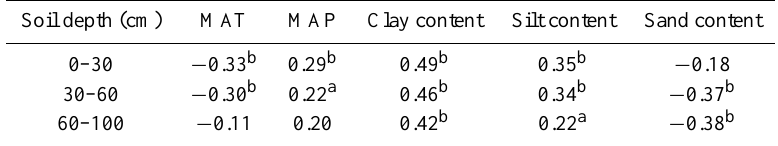
Table 3. Correlation coefficients between SOCD and environmental factors in different soil layers. Soil depth (cm) MAT